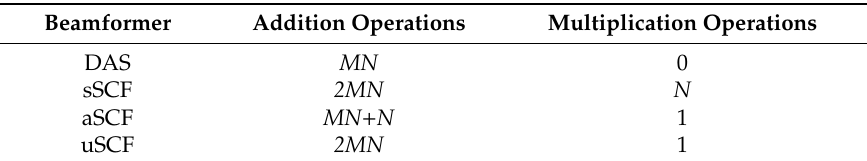
Table 4. Computational complexity for one